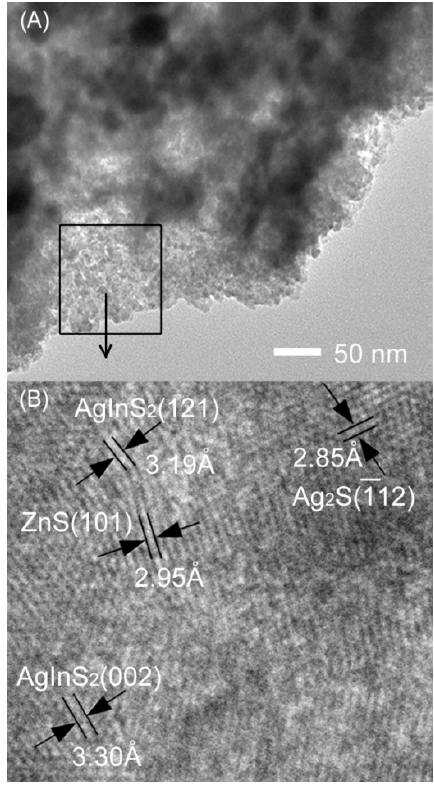
Figure 3. Transmission electron micrograph ( TEM) ( A ) and HRTEM ( B ) images of the AgInS 2 -Ag 2 S-ZnS composite nanoparticles.